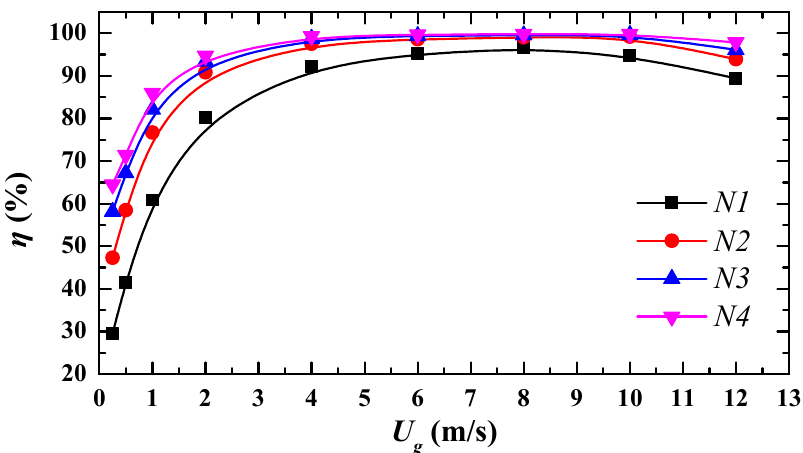
Figure 6. Numerical results of separation efficiency versus U g inside demisters with different class numbers N .